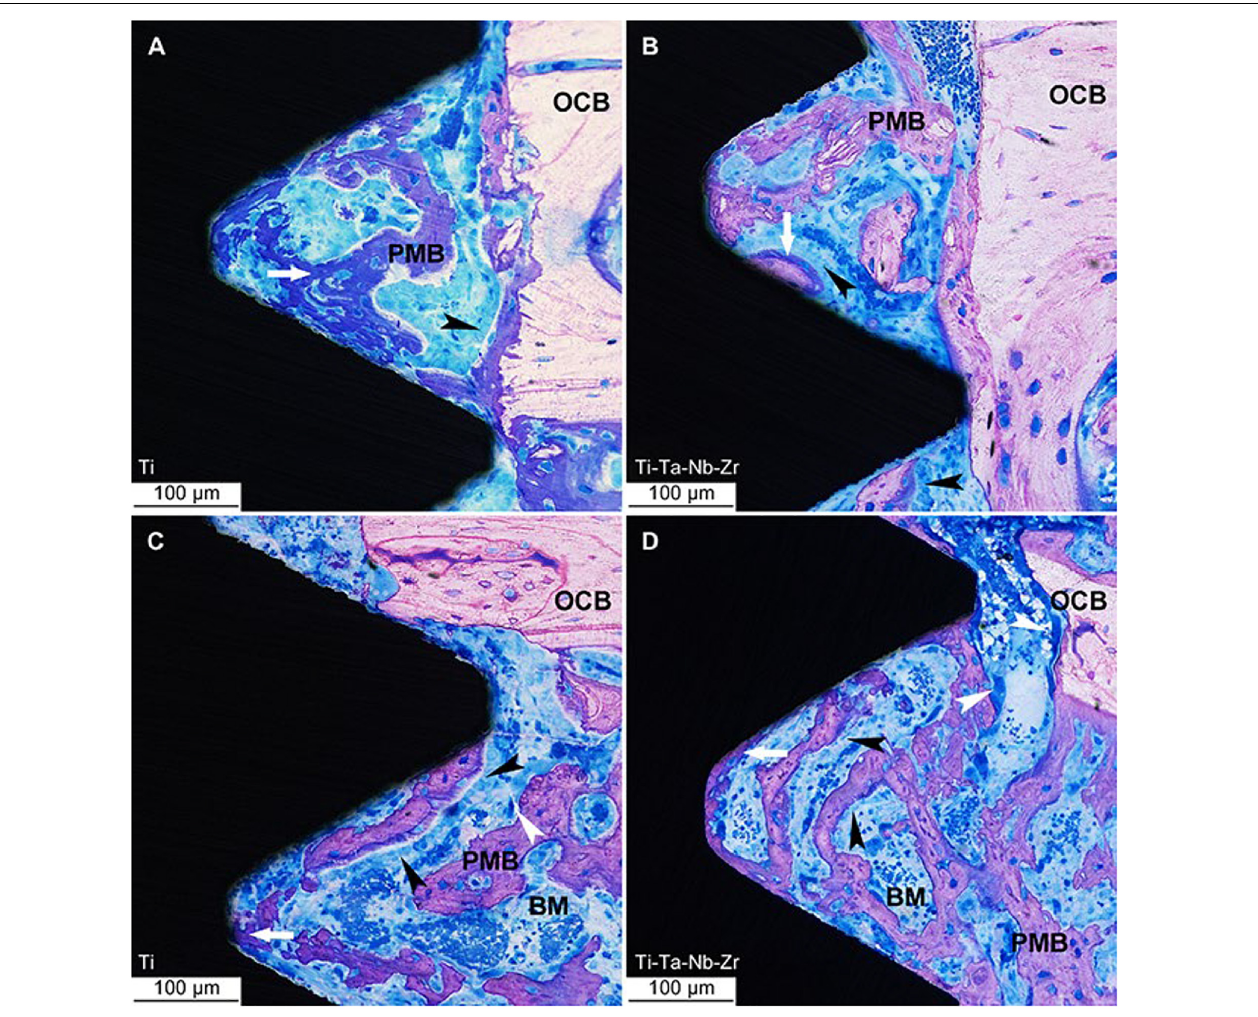
FIGURE 7 | Light micrographs of undecalcified ground sections of bone interface to Ti implants. (A–C) and Ti–Ta–Nb–Zr implants (B–D) after 7 days’ healing. OCB, original cortical bone; PMB, partially mineralized bone; BM, bone marrow; white arrow = osteoid, white arrowhead = osteoclast and the black arrowheads = osteoblast seams (Stenlund et al., 2015). Reproduced from Stenlund et al. (2015) with